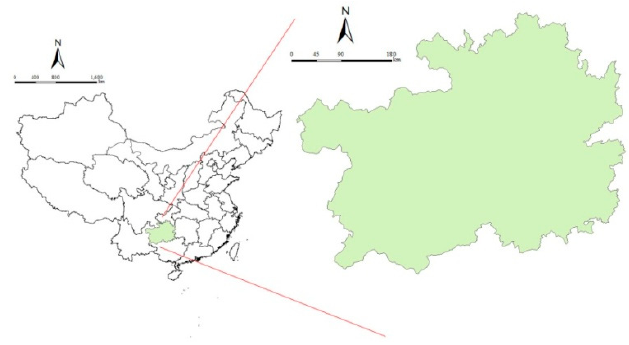
Figure 1. Map of Guizhou Province, China.